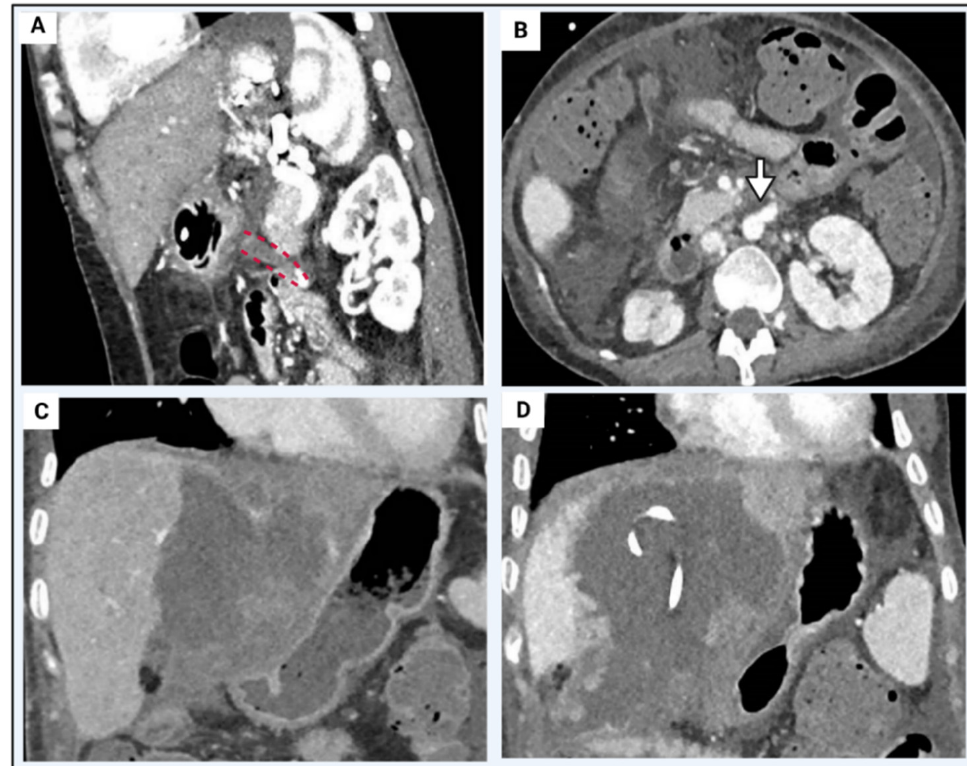
Figure 4. Liver retransplant case example. Recipient: 26 year old female, 36 kg and BMI 18. Native liver disease of cryptogenic cirrosis. Two previous transplants with graftnloss secondary to early hepatic artery thrombosis. Relisted for a third graft due to arterial thrombosis (Panel ( A ), red dashed lines) of the infrarenal aortic conduit (Panel ( B ), white arrow) and biliary sepsis with bilomas (Panel ( C )) requiring multiple percutaneous drains (Panel ( D )). Graft: 16 year old deceased brain death donor. Normal arterial anatomy and graft weight of 1.2 kg. Cold ischaemic time of 9 h 40 min, normothermic machine perfusion time of 8 h 44 min. Operation: Graft implanted via the side-side cavo-cavostomy, end-end portal vein anastomosis. New aortic conduit with donor iliac artery inserted from supracoeliac aorta to graft common hepatic artery/gastroduodenal artery patch. Redo hepaticojejunostomy. Post-operative recovery: Immediate graft function. Peak ALT 191 IU/L in first 7 days. Intensive care unit stay of 4 days, discharged from hospital on post-operative day